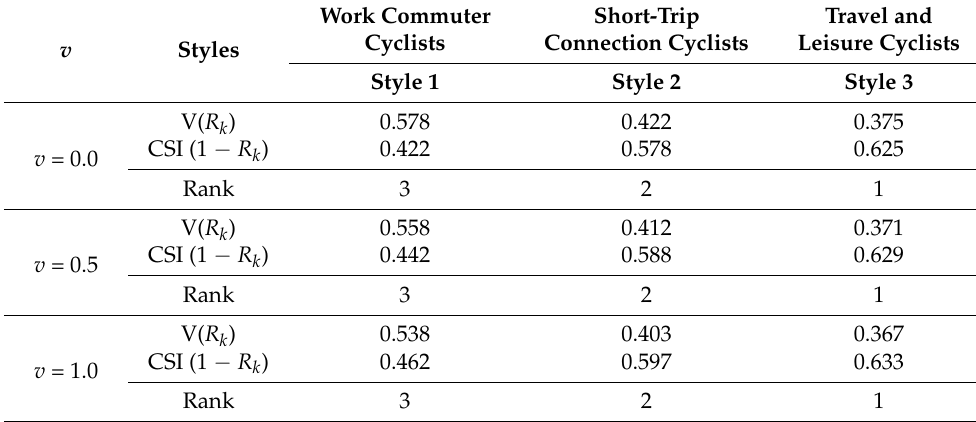
Table 19. The robustness analysis of CSI ranks for PBSSSs. Work v Styles